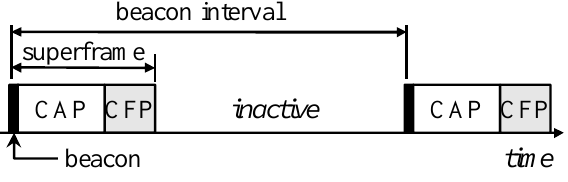
Figure 5. Superframe structure in IEEE 802.15.4 LR-WPAN with beacon enabled mode.